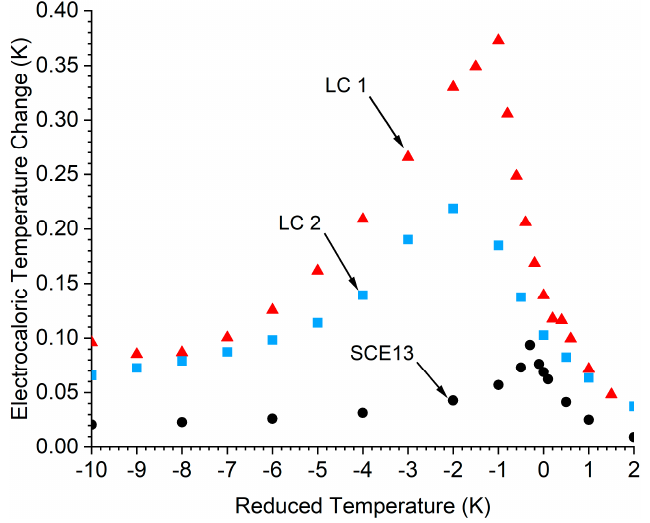
Figure 5. Indirect measurement of the electrocaloric temperature change as a function of reduced temperature for a field strength of 16 V µm − 1 SCE13 (black circles) and LC 1 (red triangles) and 14 V µm − 1 for LC 2 (blue squares). The peak position occurs at reduced temperatures of ~ − 0.3 K (SCE13), ~ − 1 K (LC 1), and ~ − 2 K (LC 2).